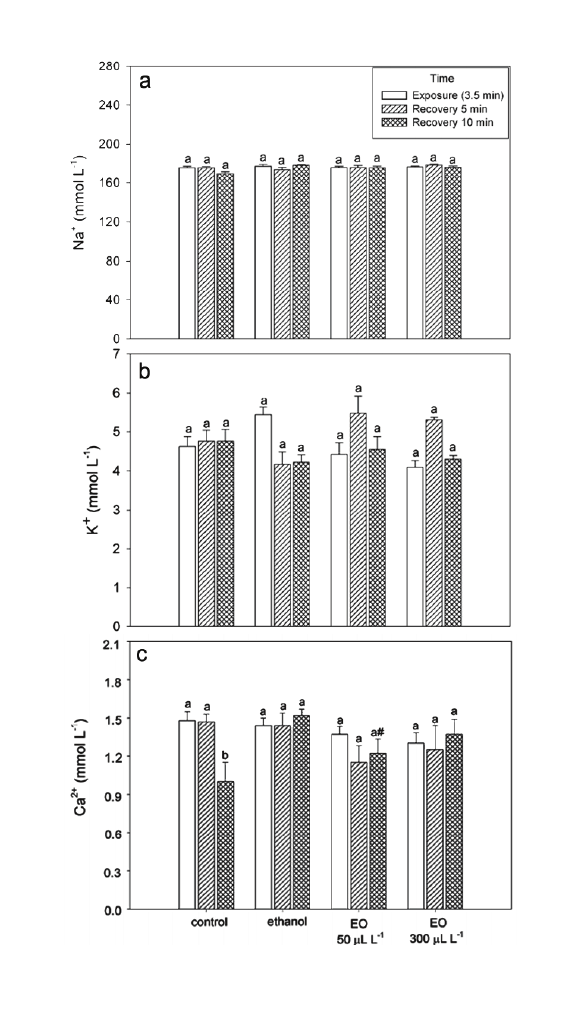
Figure 2 - Plasma Na + ( a ), K + ( b ) and Ca 2+ ( c ) levels in Epinephelus marginatus after exposure to essential oil (EO) of Aloysia polystachya added to the water (n = 6 animals per group). Values are represented as mean ± SEM. Different letters indicate significant differences between times in the same treatment (P < 0.05). * indicates significant difference from the control group at the same time and # indicates significant difference from the ethanol group at the same time (P <